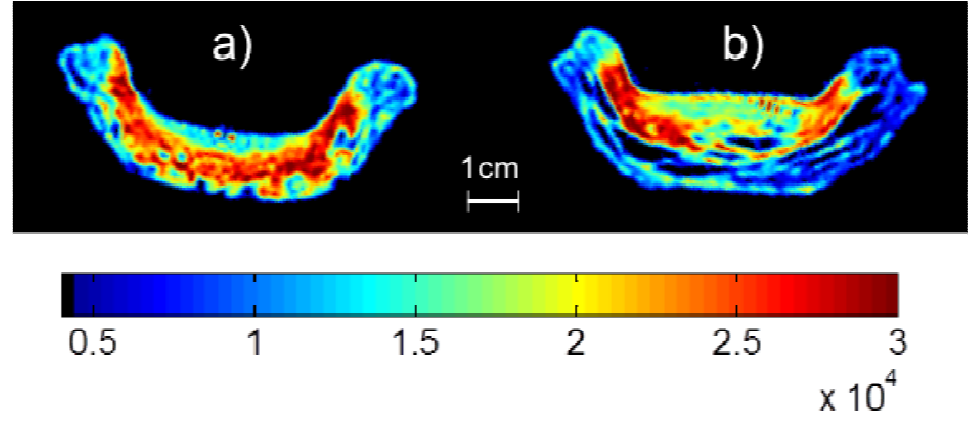
Figure 3. Single Point Images of pastry with jelly produced after concentration times of ( a ) 30 min and ( b ) 120 min corresponding to moisture contents of 98.9% and 97.4% respectively. The color scale represents the MR signal intensity with blue representing low signal intensity (e.g., pastry without jelly due to low moisture content) through green to red which represents high signal intensity (e.g., jelly due to high moisture content).